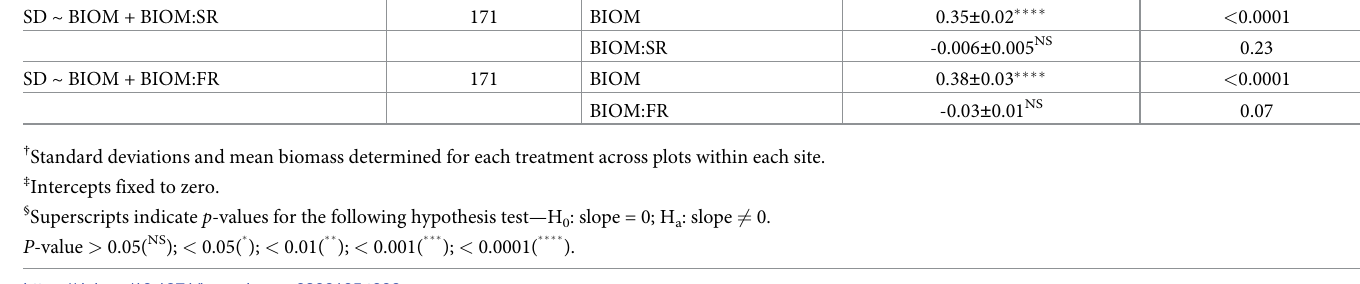
0 : slope = 0; H a : slope 6¼